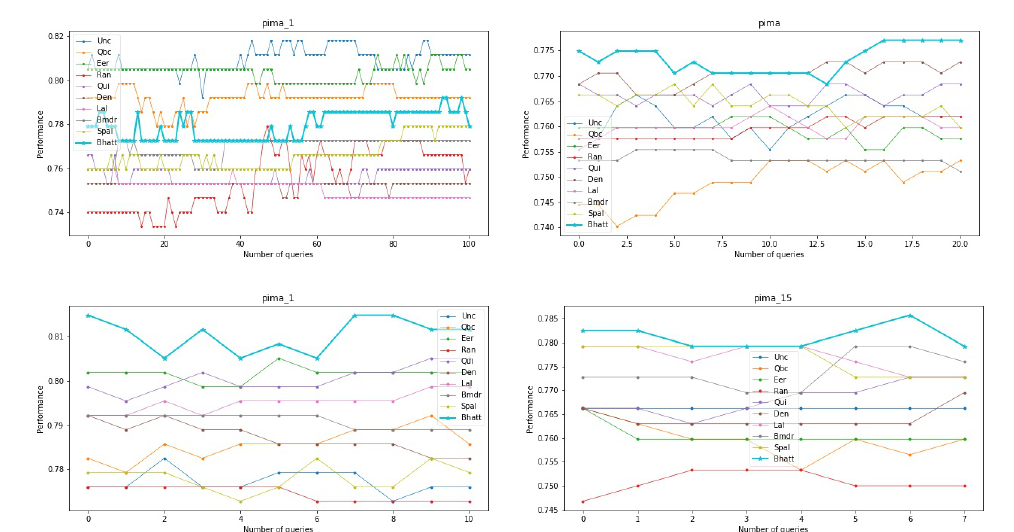
Figure 4. Performance comparison on the Pima dataset, and it can be found that, when batch_size = 5, the performance is the best, and the rising trend of accuracy improvement is also the most obvious, which is suitable for the application of actual scenes.